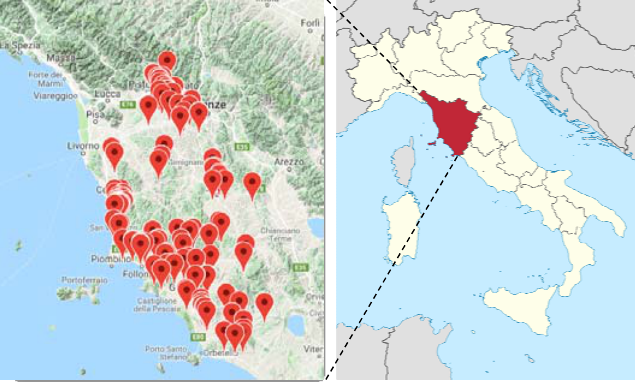
Figure 10. The samples collected from each area are indicated with map markers in the expansion of the Tuscan region (Italy). (from http://www.progettott.info/www/MappaNMR.php; https://en.wikipedia.org/wiki/Tuscany).